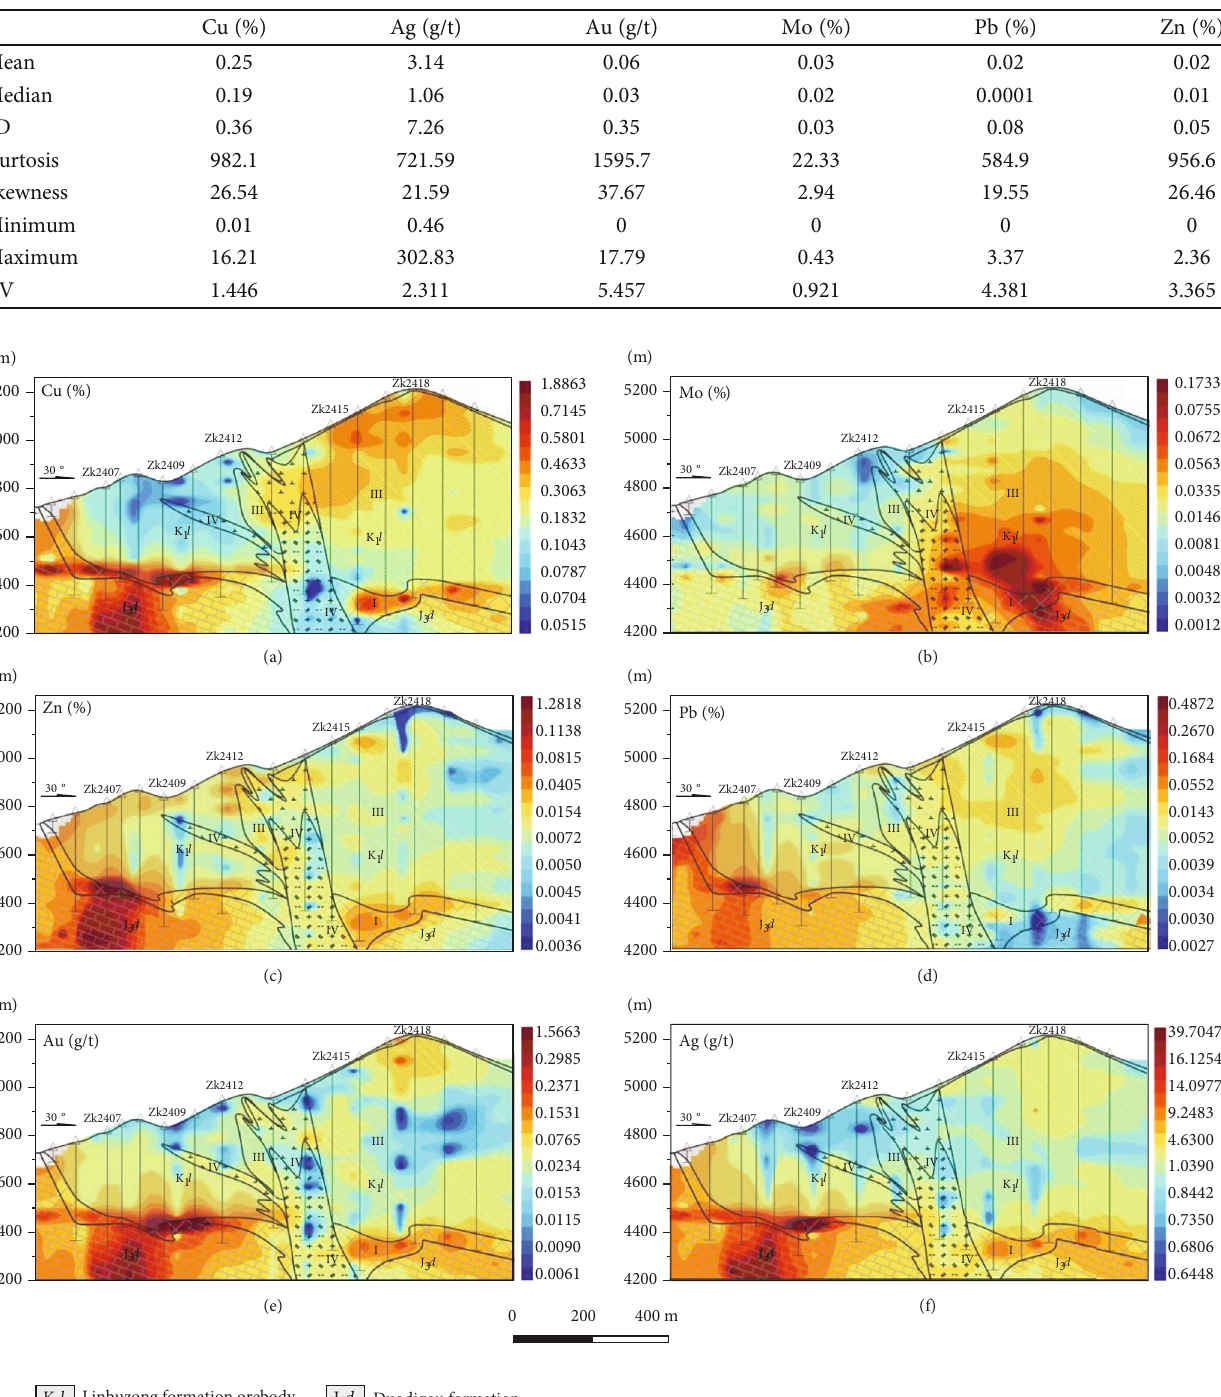
Table 2: Statistical numerical distribution parameters for the #24 exploration pro fi le (SD: standard deviation; CV: coe ffi cient of